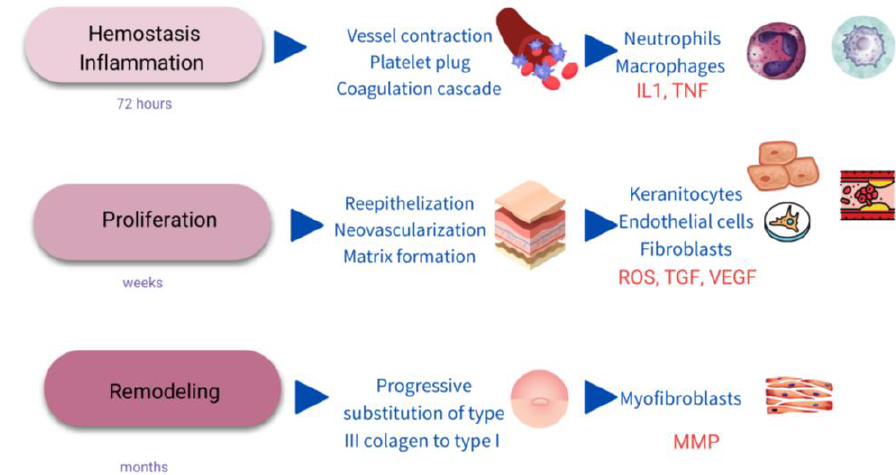
Figure 1. Scheme of the stages of wound healing. IL1: interkeukin1; TNF: Tumor necrosis factor; ROS: single oxygen radicals; TGF: transforming growth factor; VEGF: vascular endothelial growth factor; MMP: metalloproteinases.